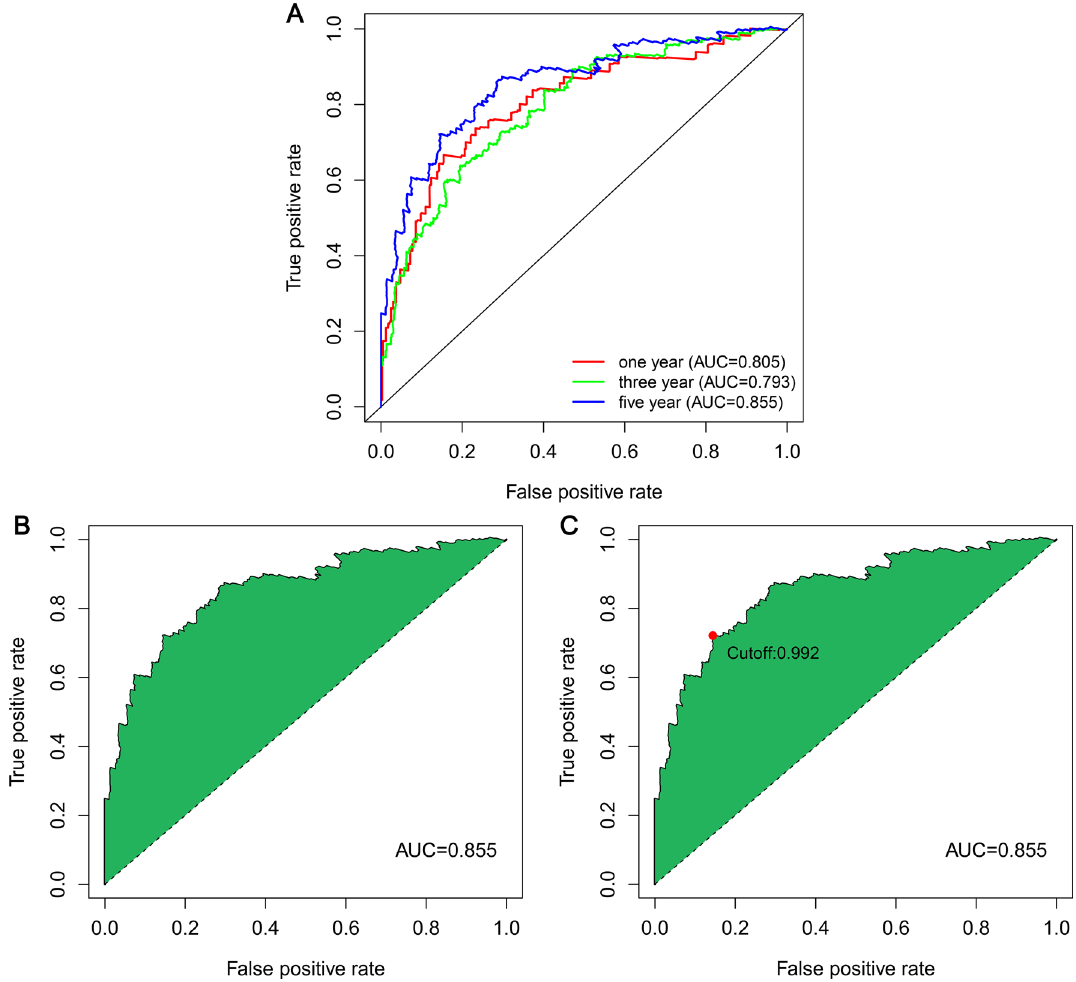
Figure 3. ROC curve based on the model value at risk. ( A ) The 1-, 3-, and 5-year ROC curves and AUCs of the optimal model. ( B ) The optimal ROC model corresponding to the maximum AUC. ( C ) The optimal cutoff value was 0.992, obtained by the Akaike information criterion and utilized to differentiate the high-risk and low-risk Correlation of immune‑cell infiltration and risk model. We presented data representing the link of the tumor immune microenvironment with the risk model (Fig. 7 and Supplementary Table 6). Spearman cor- relation analysis revealed that the high-risk group was strongly linked to the tumor-infiltrating immune cells, including T cell CD4 + Th1, Macrophage M0, Cancer-associated fibroblast, T cell CD4 + Th2, common lymphoid progenitors, uncharacterized cells, T cell CD4 + memory activated and neutrophils (Supplementary Fig. 1). Aging is involved in the immune regulation of LUAD, including regulating T cell apoptosis, the T cell receptor signal pathway, cytotoxicity mediated by natural killer cells, and B cell-mediated immunity. T cells, macrophages, B cells, NK cells, and others participate in cancer immune surveillance through immune recognition and kill- ing malignant cells. Immune cell infiltration in the tumor microenvironment contributes to tumor growth. The high-risk group has a higher immunoinvasive status and fewer cytotoxic lymphocyte infiltrates. Correlations between risk models and ICI‑related genes. We investigated the correlation between the ICI-related gene and the risk model and found that the expression levels of CTLA4 and GAL9 differed between the groups (p < 0.05, Fig. 8A,B). The CTLA4 gene was subjected to upregulation in the high-risk group, while the level of the GAL9 gene was elevated in the low-risk group. These two genes can be used as immu- notherapy targets in the high- and low-risk groups, respectively. HAVCR2 (p > 0.05, Fig. 8C), LAG3 (p > 0.05, Fig. 8D), PD-1 (p > 0.05, Fig. 8E), PD-L1 (p > 0.05, Fig. 8F), PD-L2 (p > 0.05, Fig. 8G) and TIGIT (p > 0.05, Fig. 8H) did not show significant differences. Correlation between risk model and chemotherapeutic drugs. Docetaxel (Fig. 9B), erlotinib (Fig. 9C), gefitinib (Fig. 9D), and paclitaxel (Fig. 9E) showed significantly different sensitivities in the high- and low-risk groups, while cisplatin (Fig. 9A) showed no significant difference. In the high-risk group, the IC 50 val-